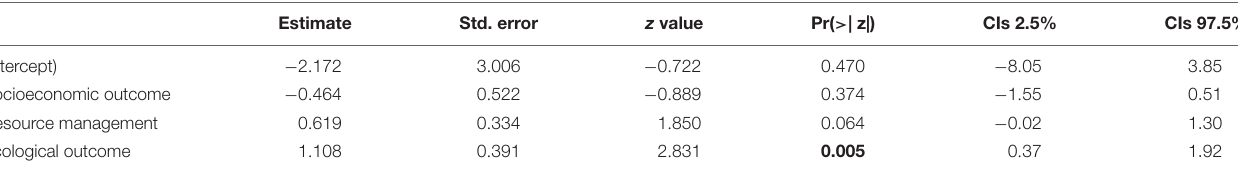
TABLE 6 | Results of generalized linear model shows factors that drives fisher’s (engaged in hilsa fisheries) willingness to comply with fishing ban based on fishers’ survey. Estimate Std. error